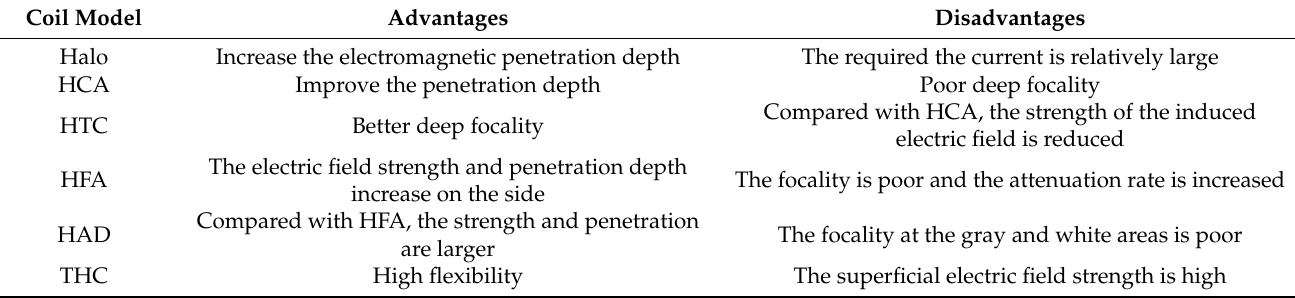
Figure 9. The structure of the Halo coil and related combinations. ( a ) Halo coil. ( b ) HCA coil. ( c ) HTC Table 3. Characteristics of the Halo coil model.